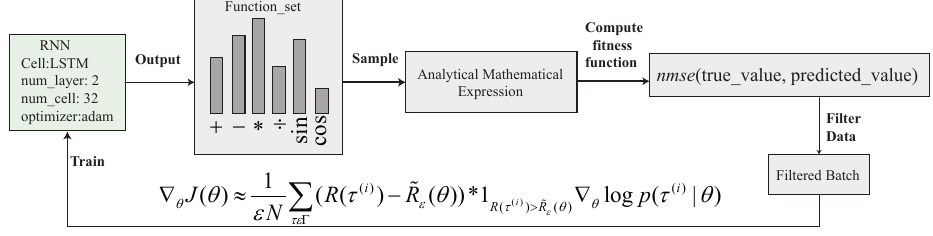
Figure 3. Deep symbolic regression core